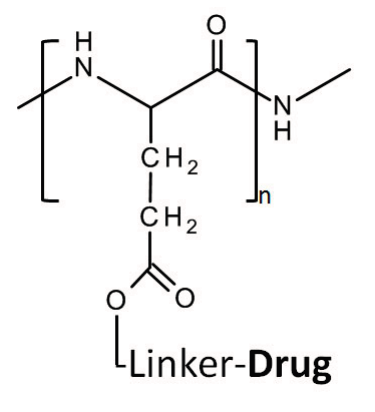
Figure 5. Structure of PGA and its drug